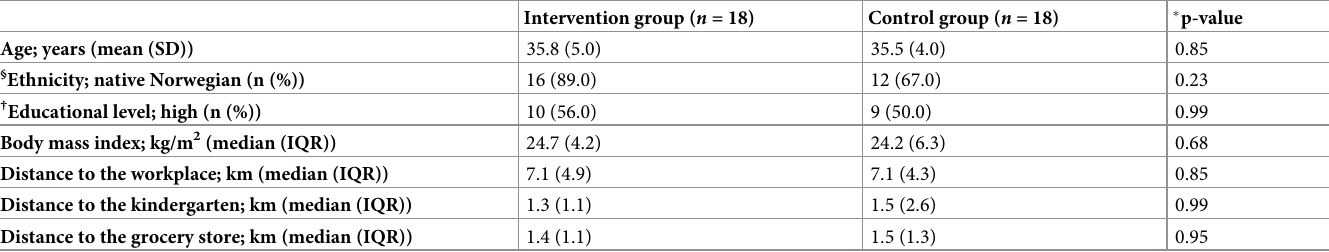
Table 1. Baseline characteristics across intervention and control group